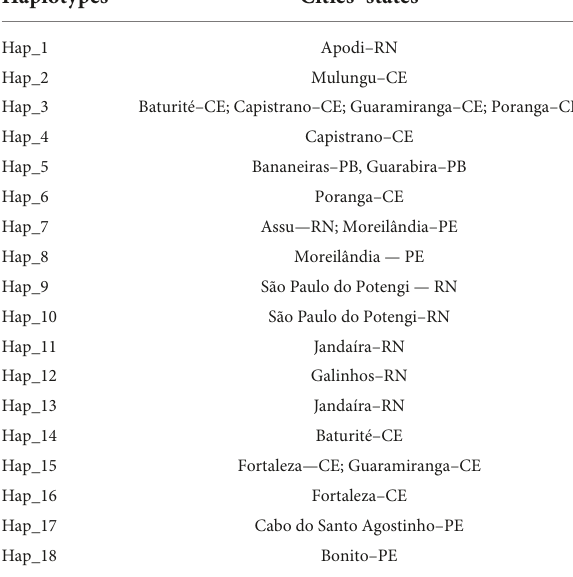
TABLE 5 Locations where each haplotype of Plebeia flavocincta was originally found.